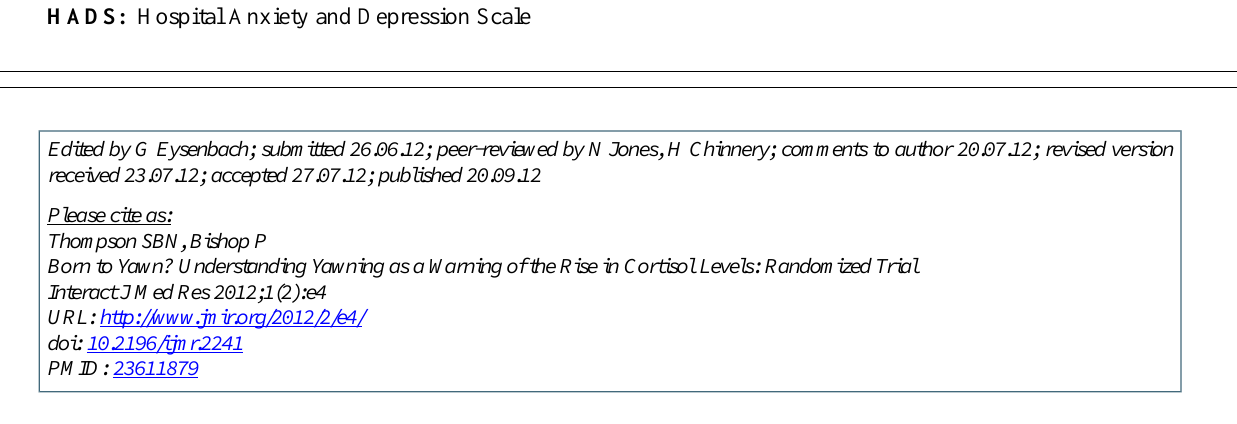
GHQ-28: General Health Questionnaire-28 HADS: Hospital Anxiety and Depression